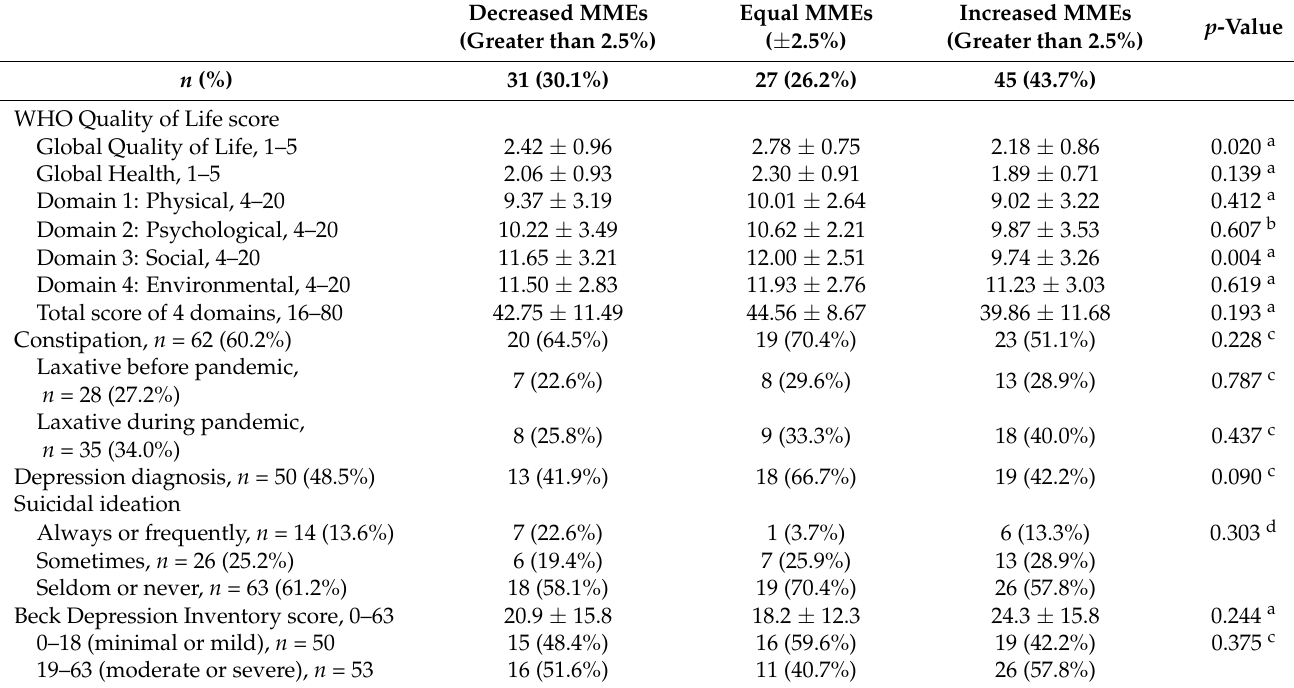
Table 3. Quality of life and depression scores among patients with chronic noncancer pain ( n = 103). Decreased MMEs (Greater than